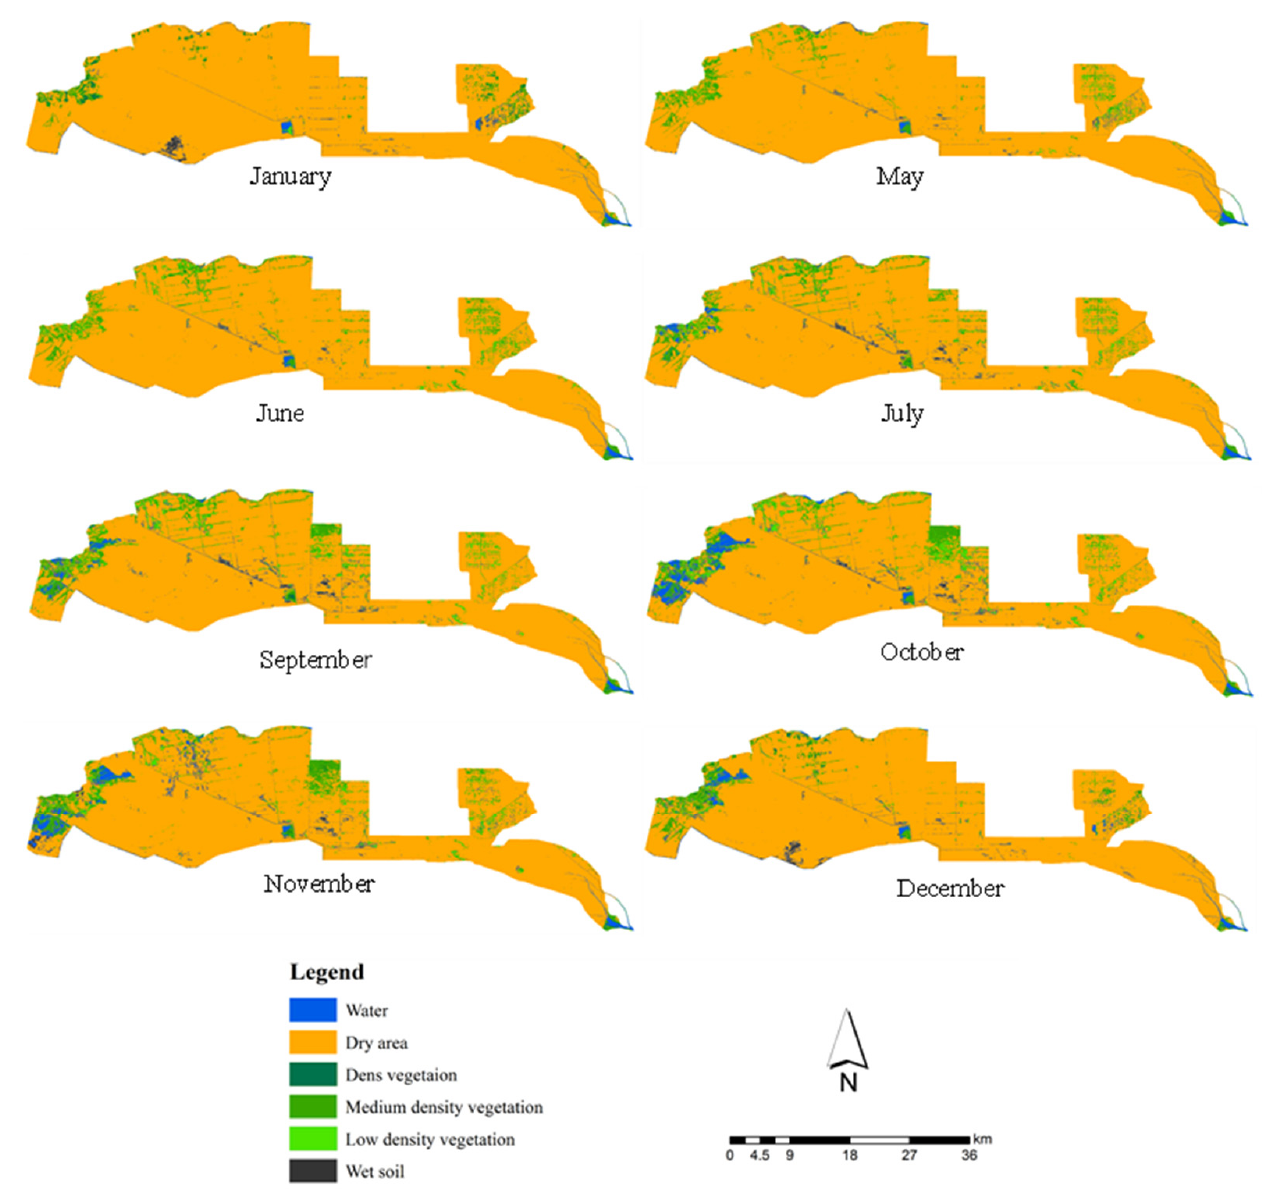
Figure 7. The extent of the marshland after the drains (2002).